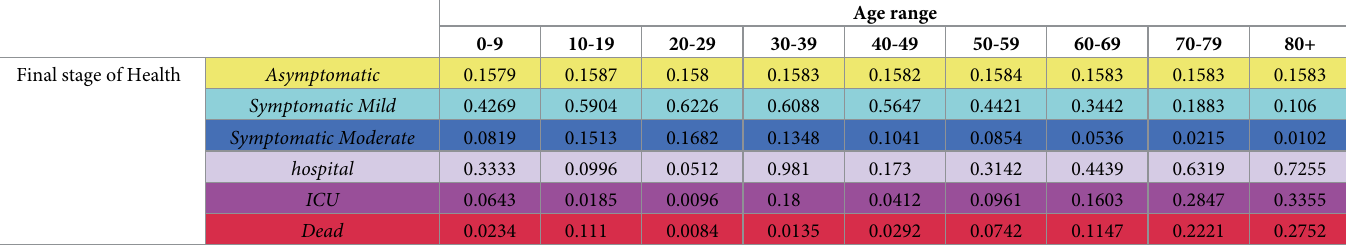
states are the only ones in which the agent can transmit the disease, which is an optimistic Table 2. Health state probability disease by age range. Each health state is related to an age range, showing the outcome state that an agent reaches in case of infection.